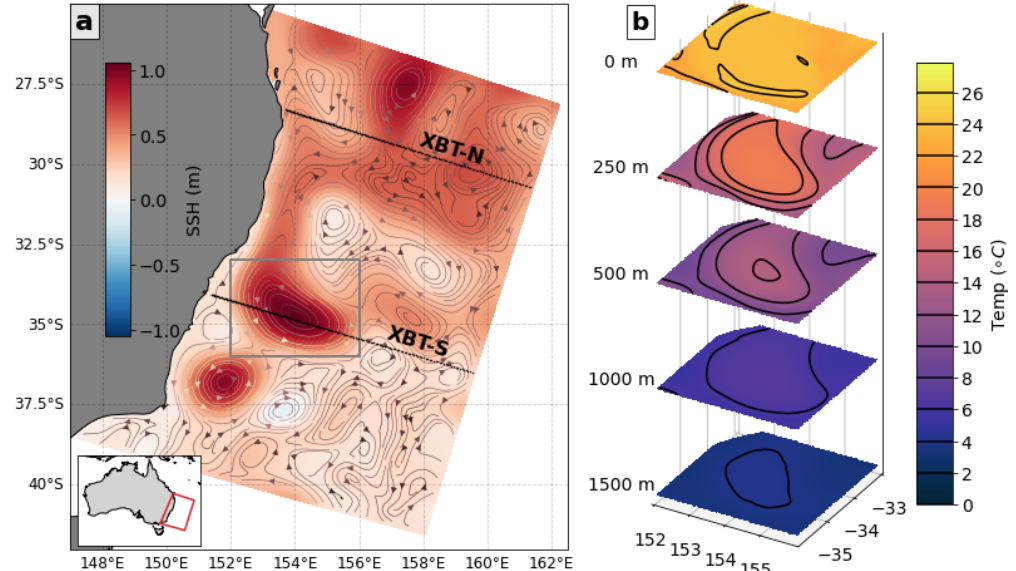
Figure 1. (a) The East Australian Current region is shown, with lines of subsurface observations marked in the north (XBT-N) and south (XBT-S) of the domain (black lines). The colour map shows the mean model sea surface height (SSH) during the 6–12 March 2012, with streamlines calculated from surface velocities marked as vectors. The study region is shown as an inset on the east coast of Australia. The grey box shows the region in focus in panel (b) , which shows the vertical structure of temperature at various levels (0, 250, 500, 1000, and 1500m) for a region focussing on an anticyclonic (warm core) eddy. Black contours of temperature are shown in (b) , with intervals marked in the colour